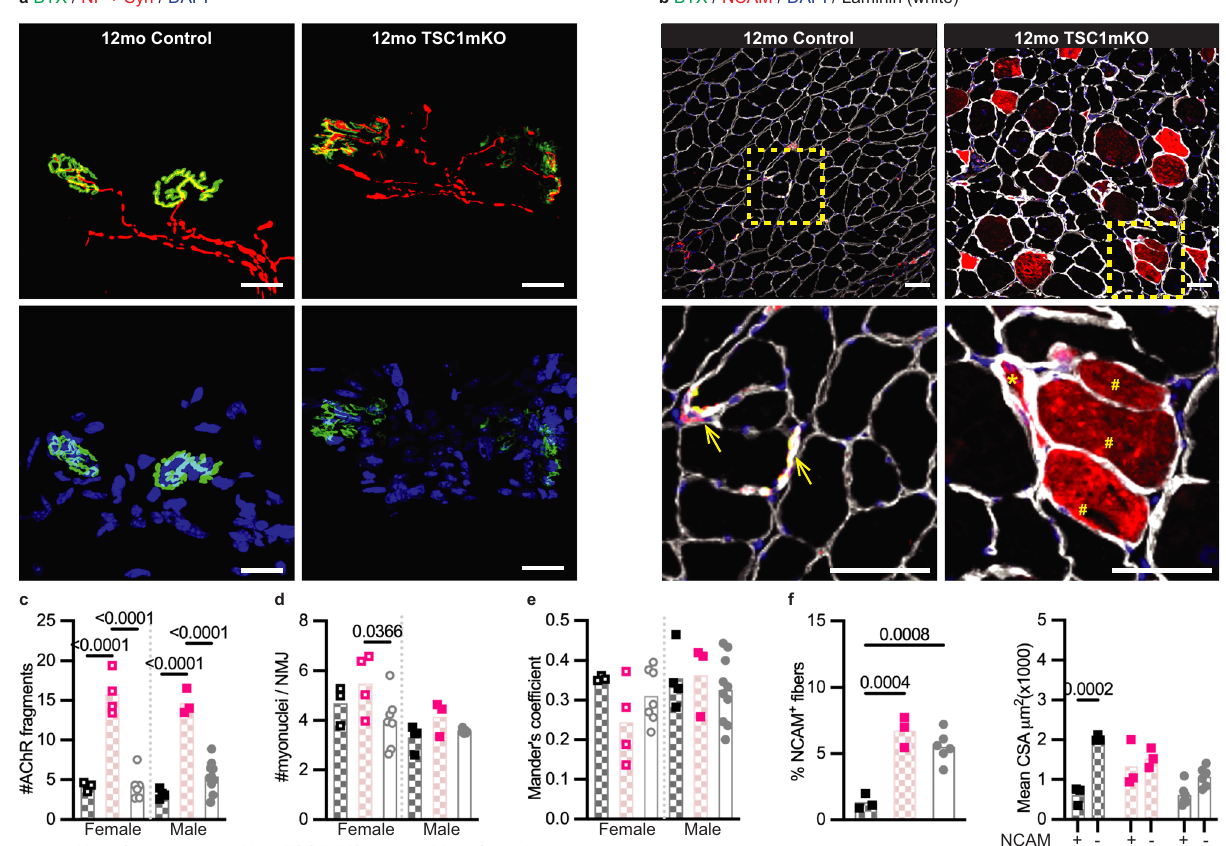
Fig. 3 | Chronic activation of mTORC1 drives sarcopenia-like NMJ remodeling. a Representative confocal images of NMJs from longitudinal sections of the quadriceps muscle of 12-month-old male mice (Control, n =4; TSC1mKO, n =3). Top panels = BTX (green) and neuro fi lament (NF; red) + synaptophysin (Syn; red); Bottom panels=BTX (green) and DAPI (blue). Scale bar=20 μ m. b Representative confocal images of BTX (green), NCAM (red), DAPI (blue) and Laminin (white) staining from cross-sections of the gastrocnemius muscle of 12-month-old male mice (Control, n =3; TSC1mKO, n =3). The insets are shown in the bottom panels. Open arrows=junctional NCAM; Asterisks=intracellular NCAM in angular, odd- shaped fi bers; Hash=intracellular NCAM accumulation in abnormally enlarged fi bers.Scalebars=50 μ m. c – e Quanti fi cationofNMJmorphologicalpropertiesthat include ( c ) the number of AChR fragmentation, ( d ) the number of post-synaptic myonuclei, and ( e ) Mander ’ s colocalization coef fi cient. Sample size: 12mo Control